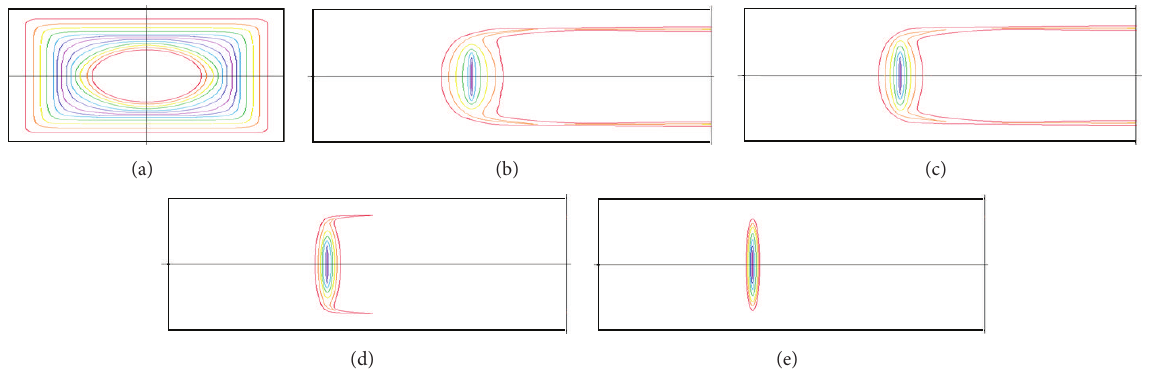
Figure 5: The contour line of particle concentration in varying position of our device: (a) position P0, (b) position P1, (c) position P2, (d) position P3, and (e) position P4.